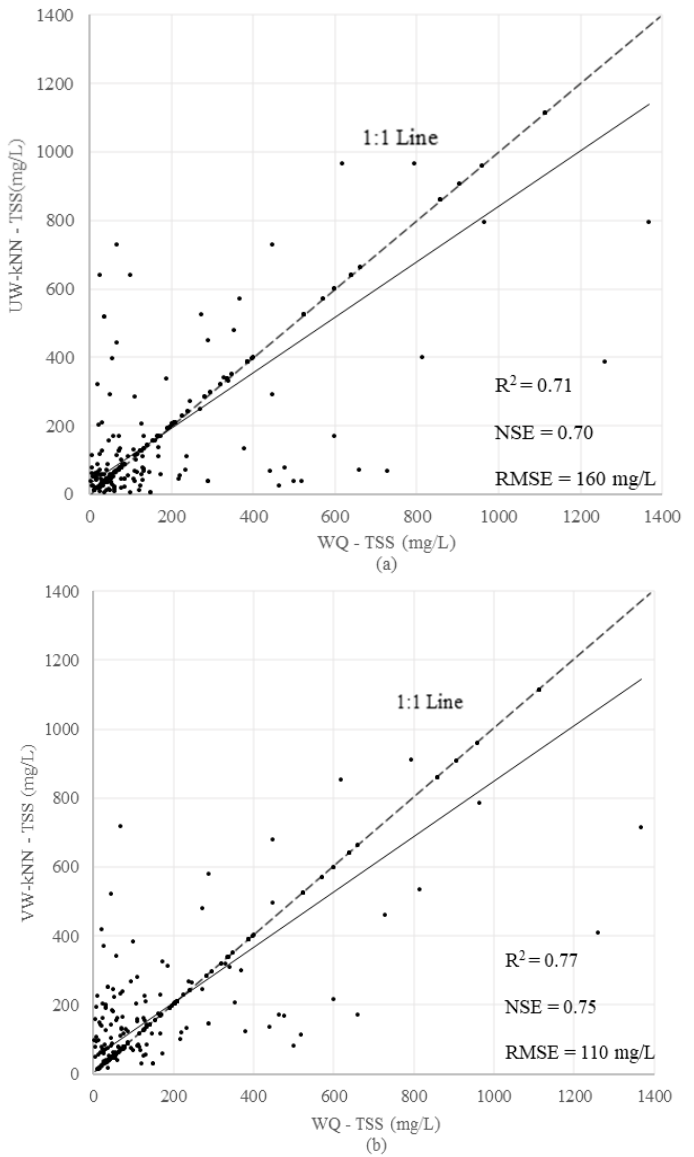
Figure 3. Correlation between the measured values and predicted TSS in the training step for ( a ) uniform weighting k- Nearest Neighbors (UW-kNN) and ( b ) variable weighting (VW)-kNN.